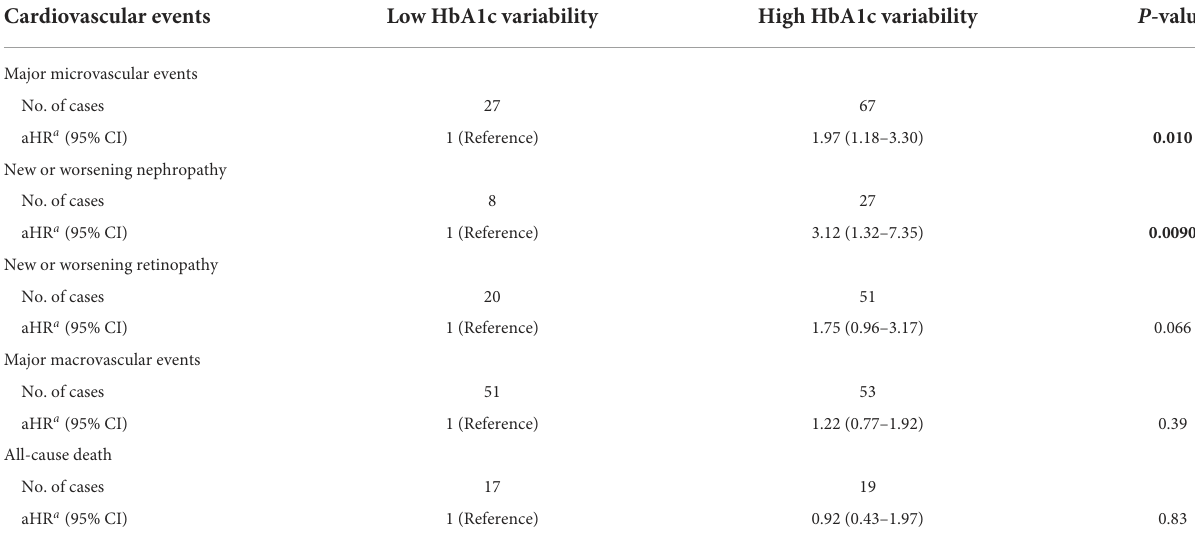
TABLE 2 The risk of cardiovascular events according to visit-to-visit HbA1c variability in all patients. Cardiovascular events